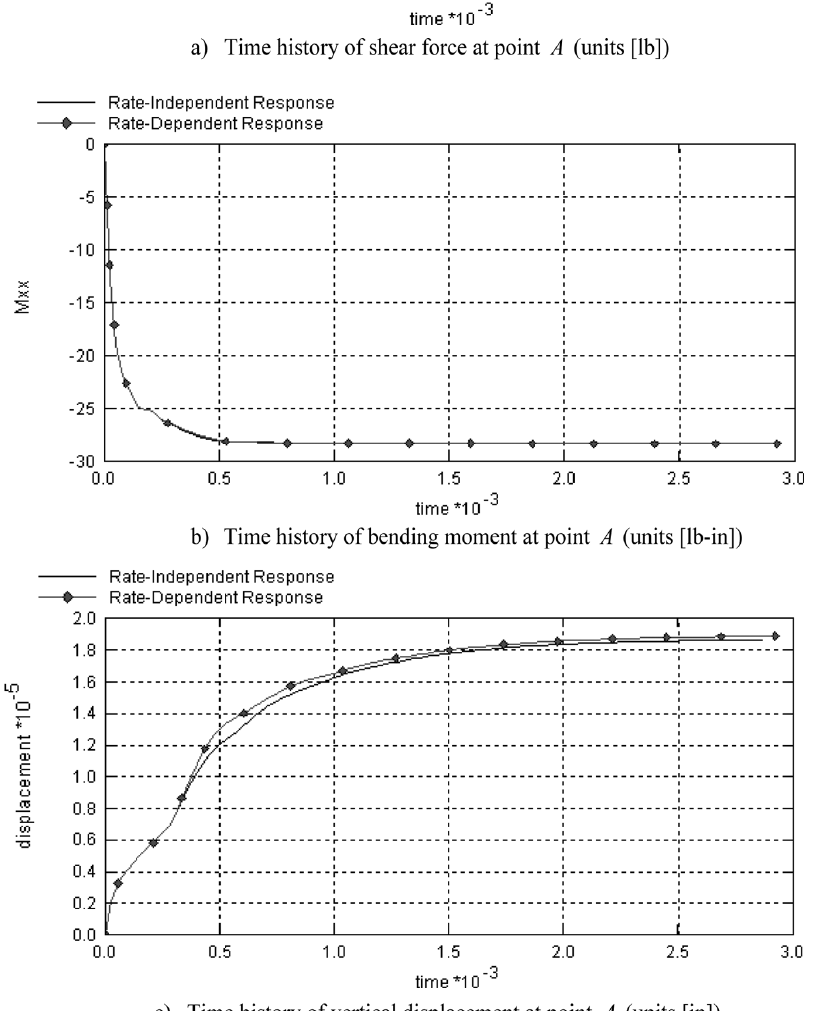
Fig. 7. Time histories of: a) transverse shear force, b) bending moment, and c) vertical displacement at point A , calculated using rate-independent and rate-dependent